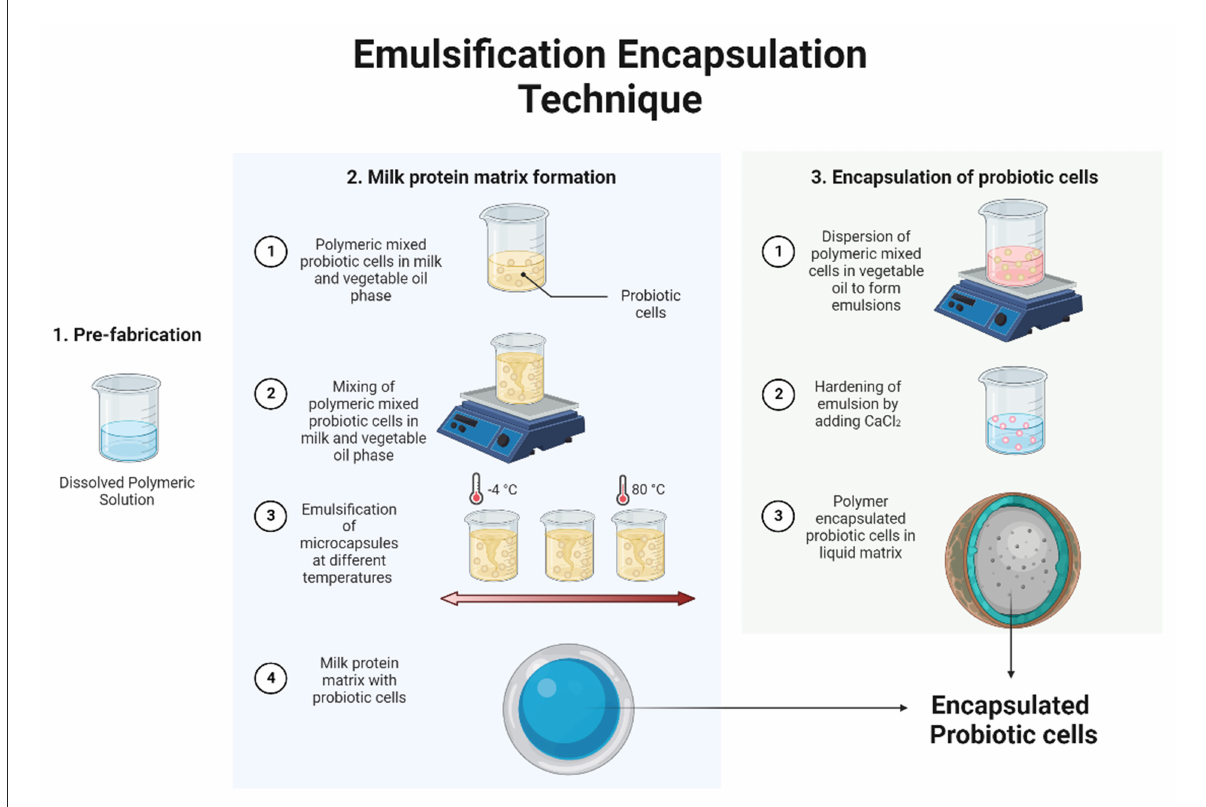
FIGURE2 Diagrammatic representation of emulsification encapsulation